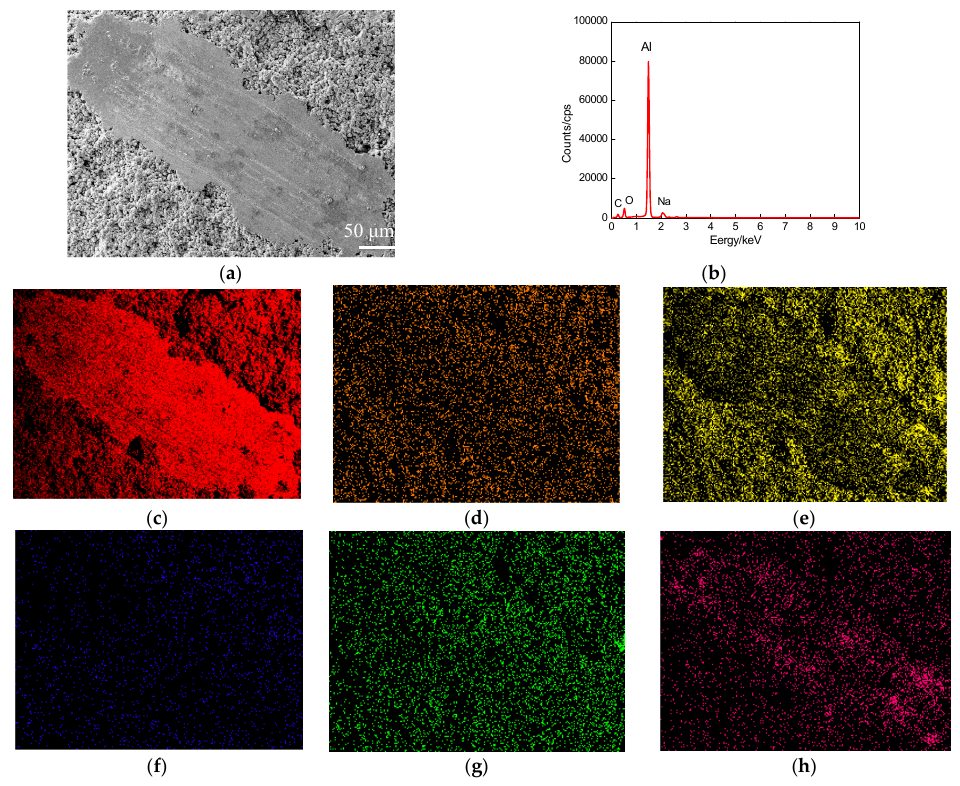
Figure 8. Plane scan analysis of worn track at wear speed of 500 times/min (wear load of 1 N). ( a ) Plane scanned position; ( b ) Result of plane scan analysis; ( c ) Al content; ( d ) C content; ( e ) O content; ( f ) Fe content; ( g ) Na content; ( h ) Cl content.